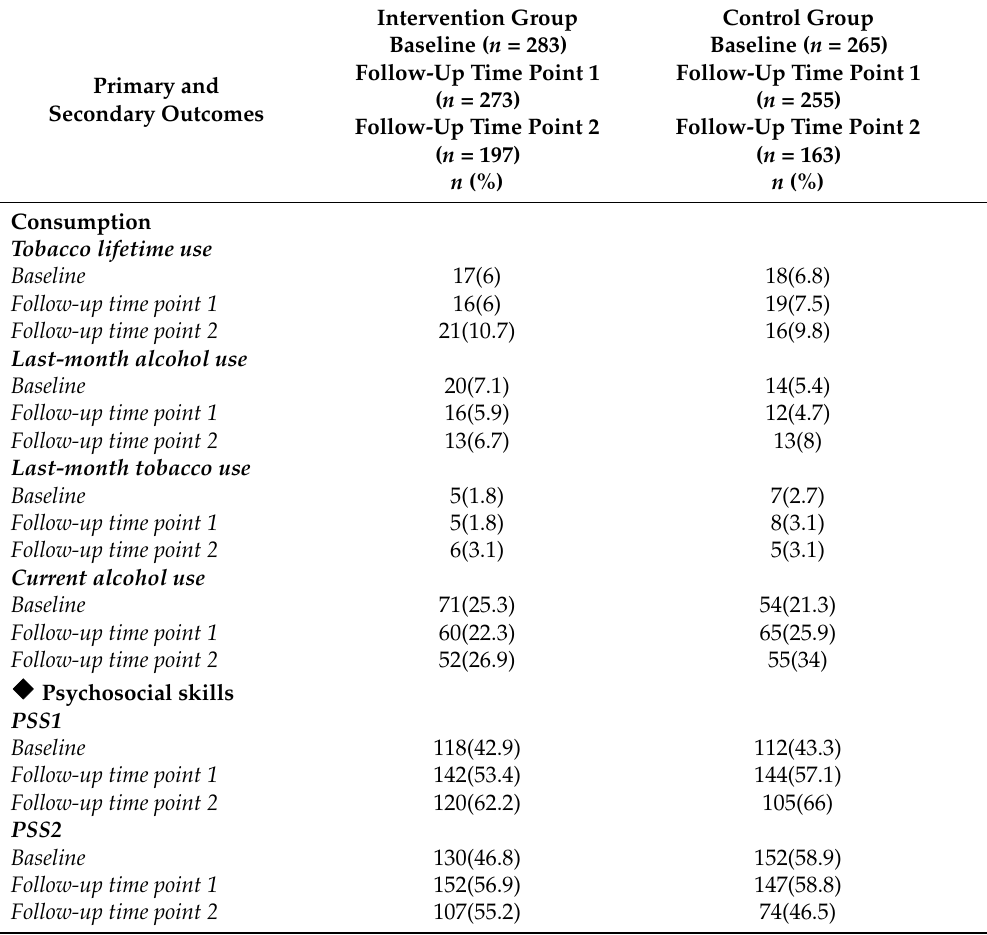
Table 1. Results of the bivariate and multivariate logistic regression analysis at baseline and across follow-up time points 1 and